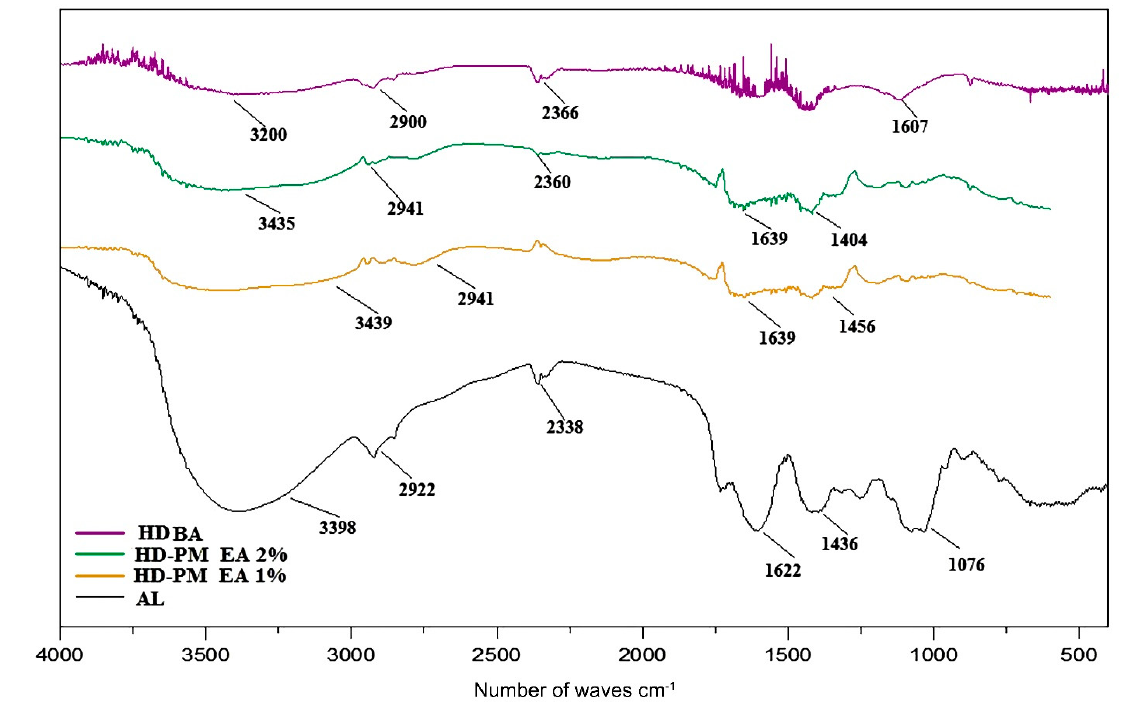
Figure 6. FTIR spectra of AL, 1% HD-PM-EA, 2% HD-PM-EA, and HD BA.